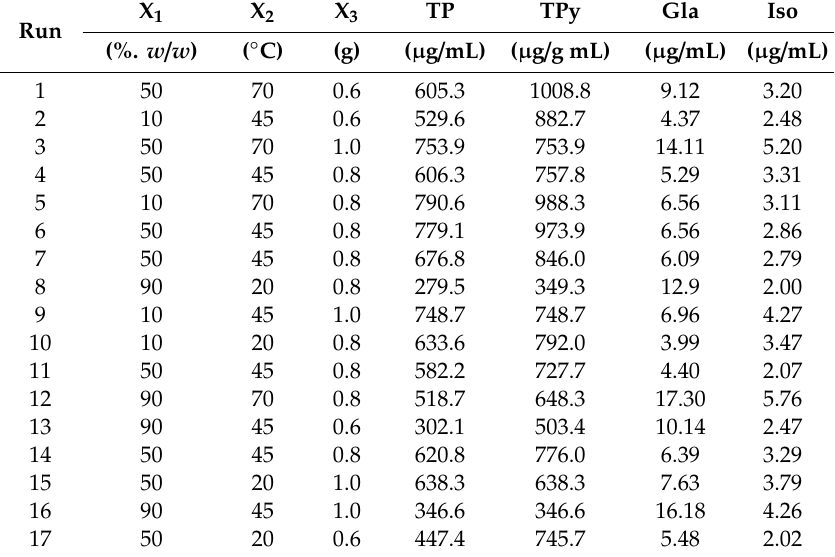
Table 2. Independent variables, their levels for the Box–Behnken design, and the responses obtained. X 1 Run